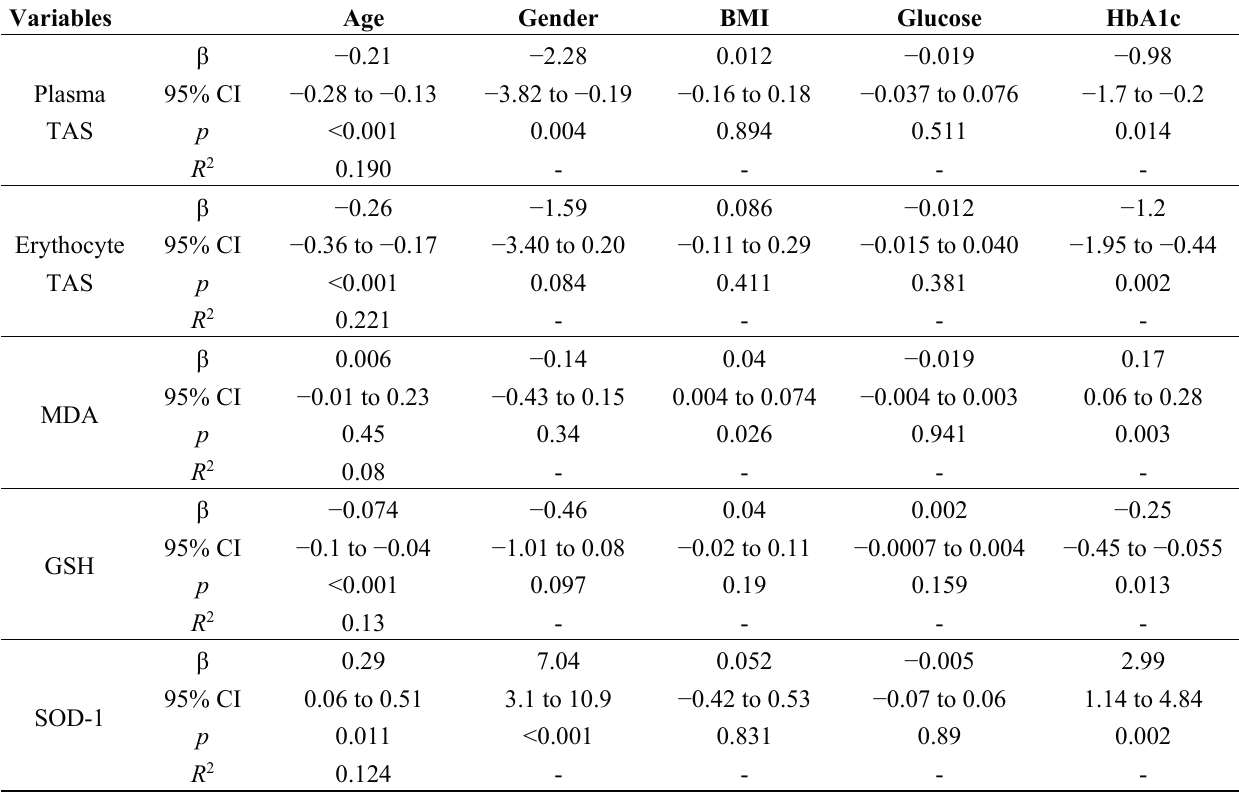
Table 2. Associations of significant redox status markers and antioxidant activities with age, gender, BMI, glucose and HbA1c in diabetic subjects. Multiple linear regressions in diabetic group and controls. Results are β , 95% CI, p of each regressor variable and R 2 of each model including plasma TAS, erythrocyte DPPH, MDA, GSH and SOD activity as dependent